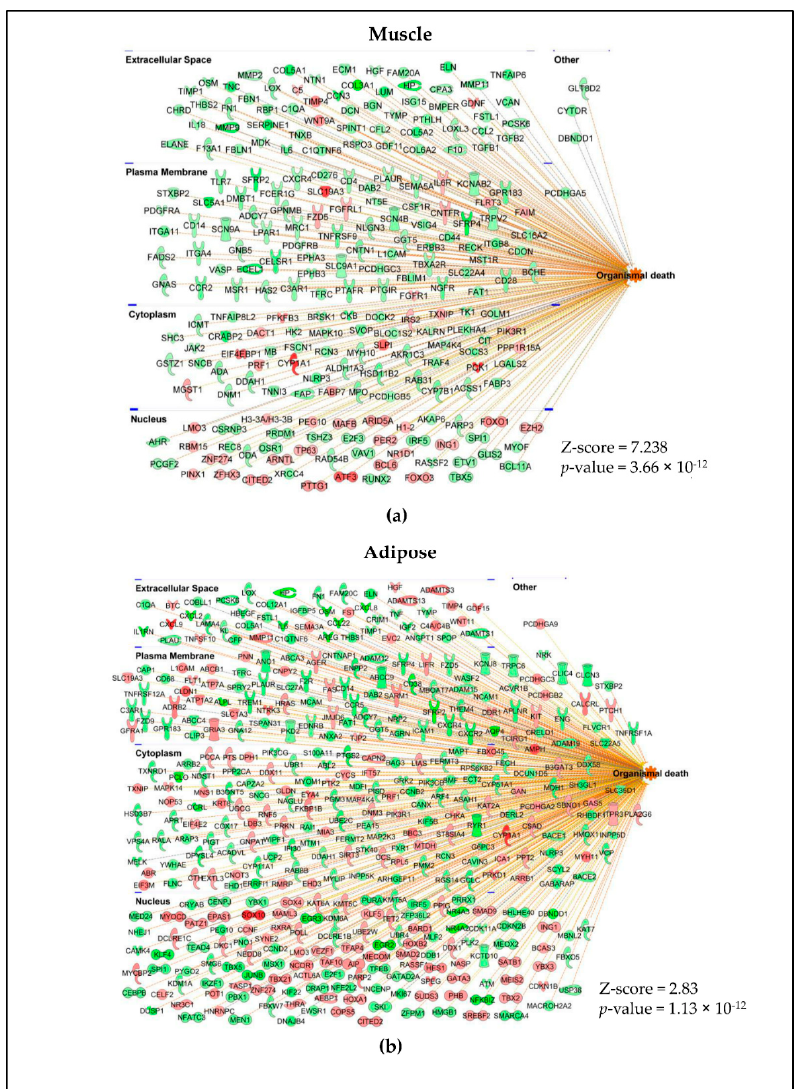
Figure 6. Gene expression predicted organismal death. Genes predicted to enhance (orange lines) or inhibit (blue lines) organismal death versus no prediction (yellow lines) in muscle ( a ) and adipose ( b ).